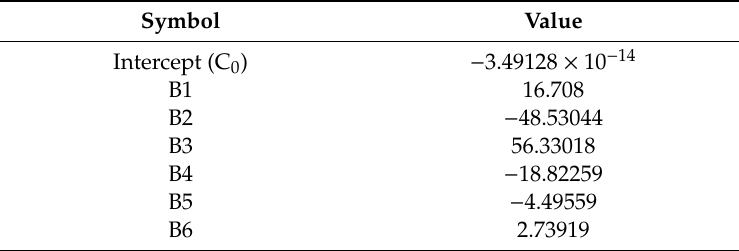
Table 4. Coe ffi cients of polynomial equation. Table 4. Coefficients of polynomial equation.